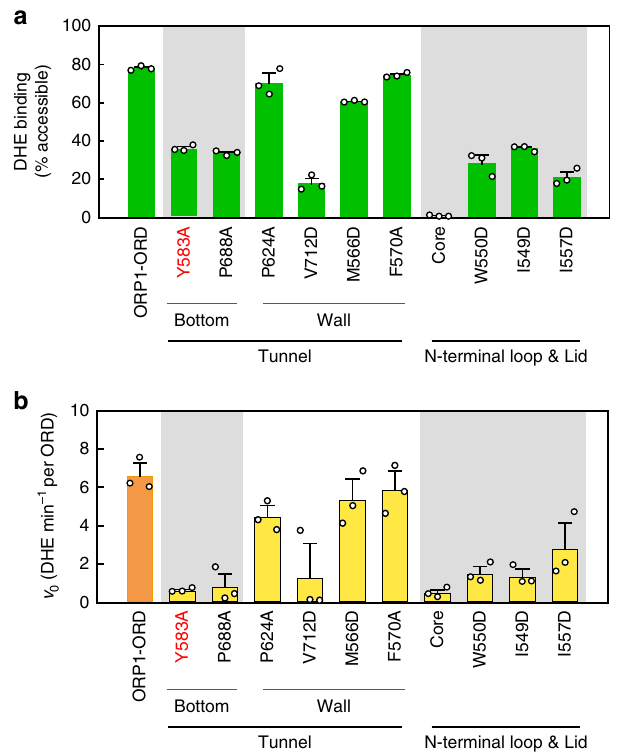
Fig. 6 Mutational analysis of the cholesterol binding site on ORP1-ORD. a DHE-binding assays of ORP1-ORD mutants. b PI(3,4)P 2 -stimulated DHE transport assays of ORP1-ORD mutations with both lipids embedded in donor liposomes. (Data are shown as mean ± s.e.m. (error bar), n =